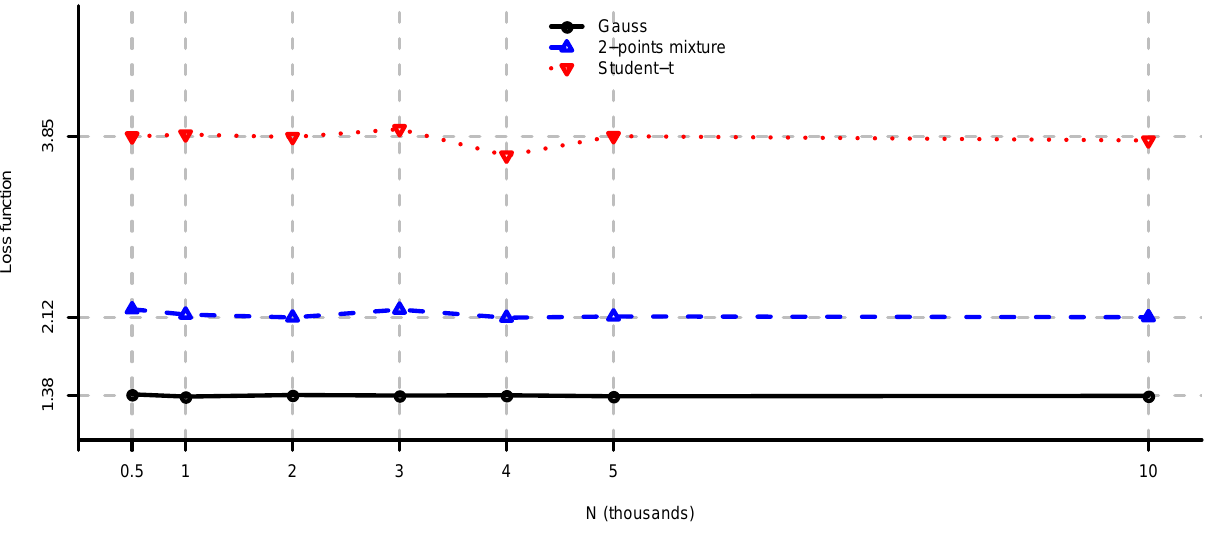
Figure 2. L ( U mv , ˆ U mv , R n ) computed using Theorem 2 for n = 50 and different values of m